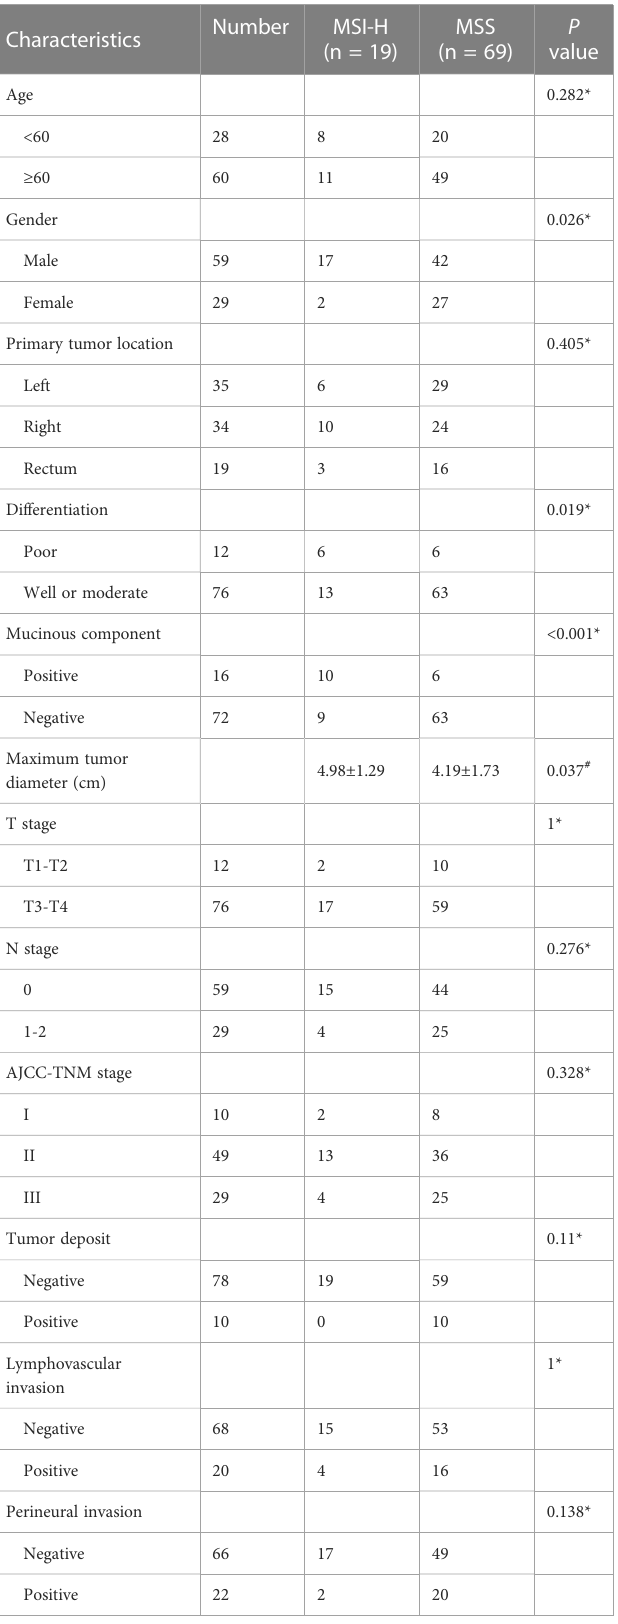
TABLE 1 Clinicopathologic characteristics of patients.